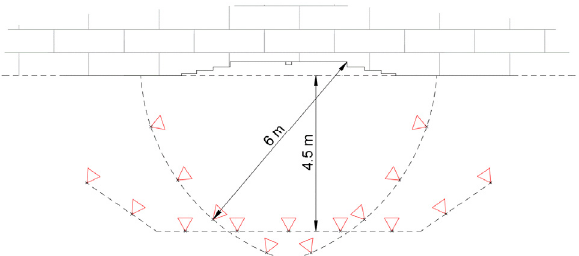
Figure 10. Planimetric camera positions (the camera positions from 3.5 m are not shown in this scheme)